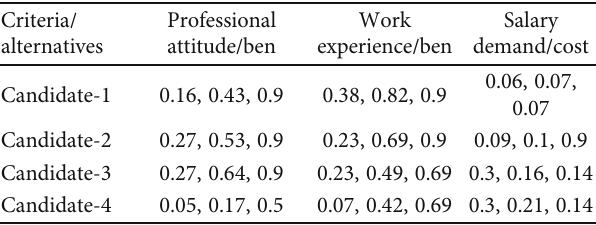
Table 5: Combined normalized weighted decision